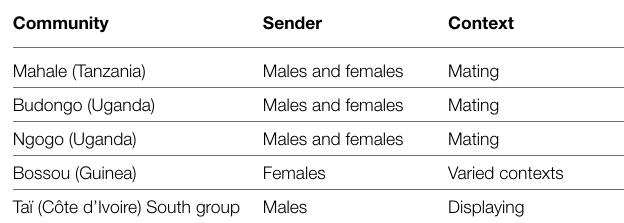
TABLE 3 | LEAF-CLIPPING in different chimpanzee communities. TABLE 1 | Group-specific gestures in the three Taï